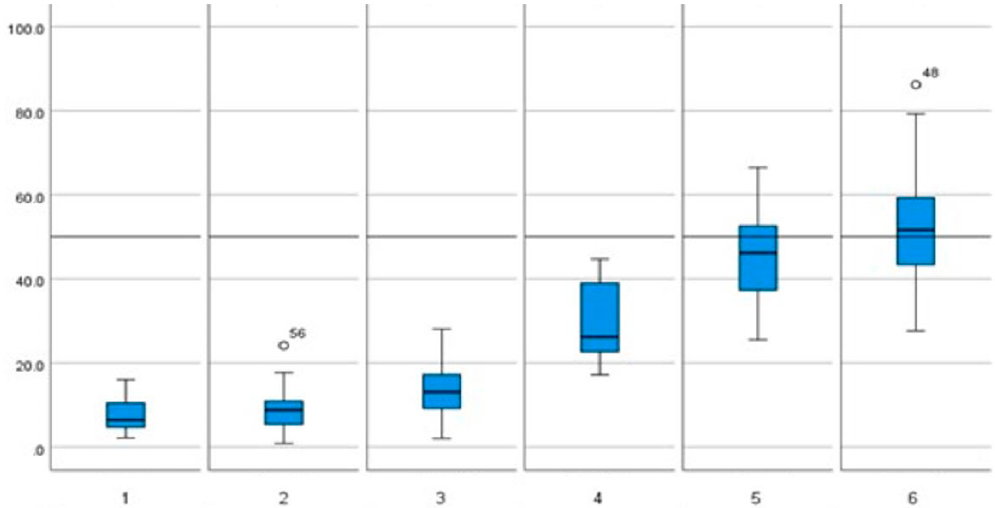
Figure 1. Proposal rate of local councils (total trend). Image edited.